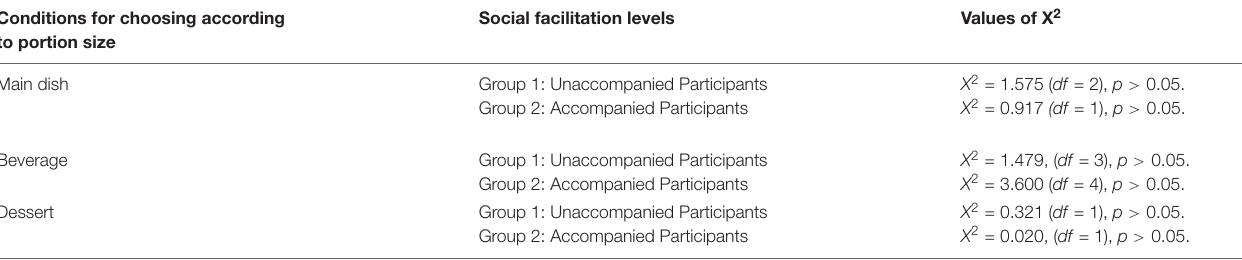
TABLE 2 | Chi-square results of main course, beverage, and dessert selection in session 2. Conditions for choosing according to portion size